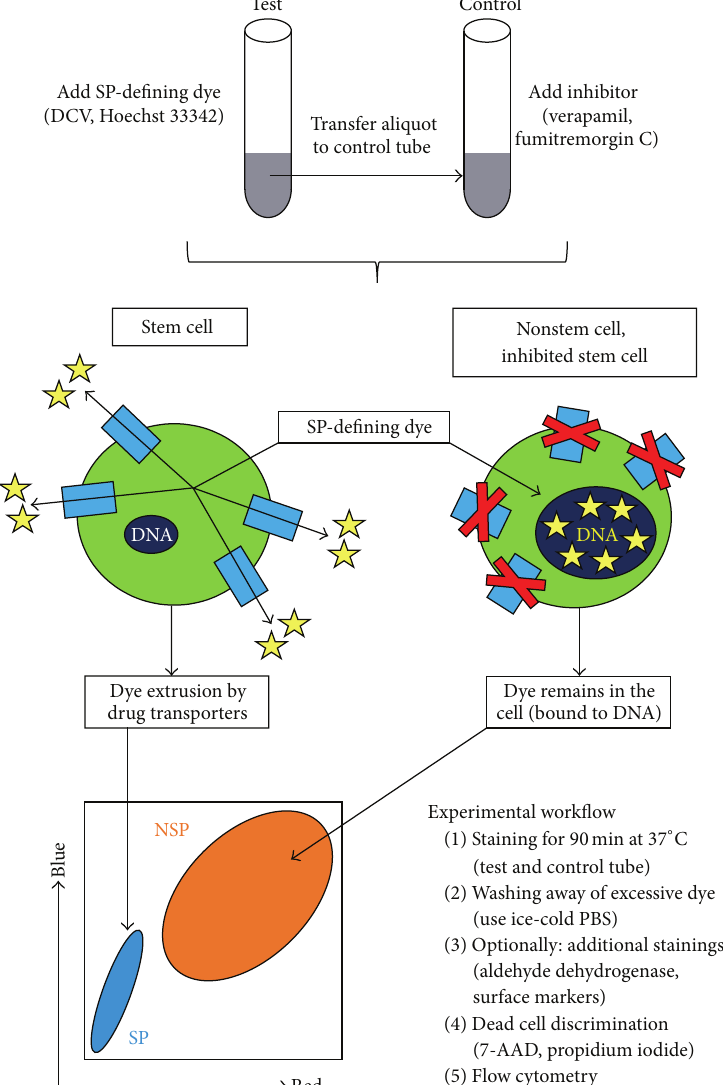
Figure 1: Principle and workflow of SP detection. SP-defining dyes are lipophilic and enter cells passively to target nuclear and mitochondrial DNA. However, binding to DNA occurs only in drug transporter-deficient (nonstem) cells, whereas stem cells prevent this event through transporter-mediated dye extrusion, a process that is suppressed upon compound inhibition. The resulting differential dye accumulation enables flow cytometric discrimination of stem cell-enriched SP and a corresponding NSP containing the bulk of differentiated cells. The experimental workflow and the underlying principle are depicted. Dye molecules are shown as yellow asterisks and membrane-spanning ABC drug transporters are shown as light blue rectangles. Dark blue ellipses within the cells refer to DNA in both the nuclear and mitochondrial